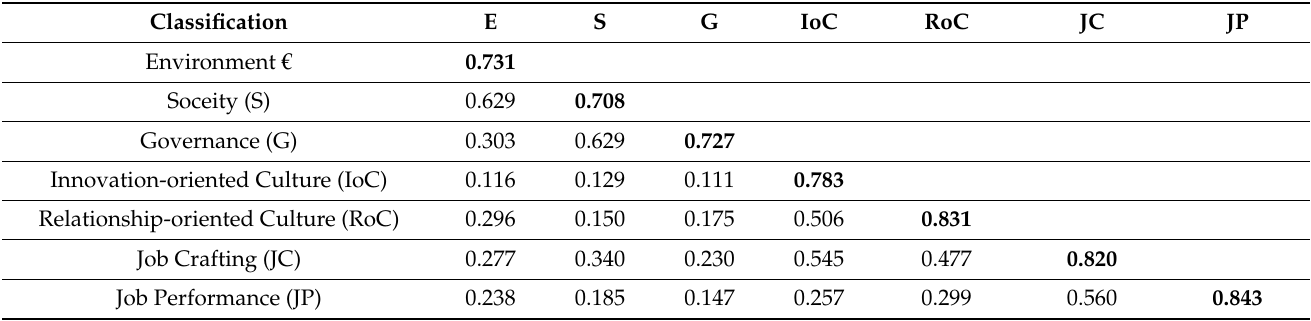
Table 4. Discriminant